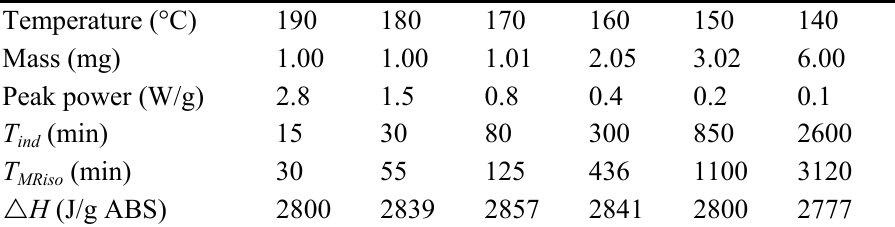
Table 2. Isothermal exothermic data of ABS powder with 60% PB.